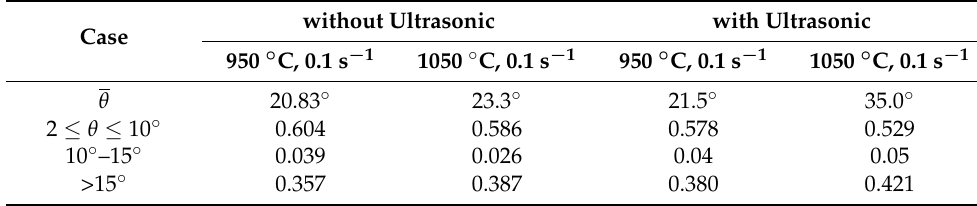
Table 2. Statistics of grain boundary misorientation angles.